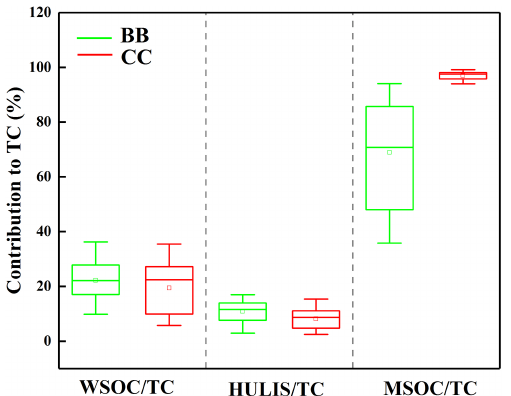
Figure 1. The abundances of BrC fraction in the smoke samples from biomass burning (BB) and coal combustion